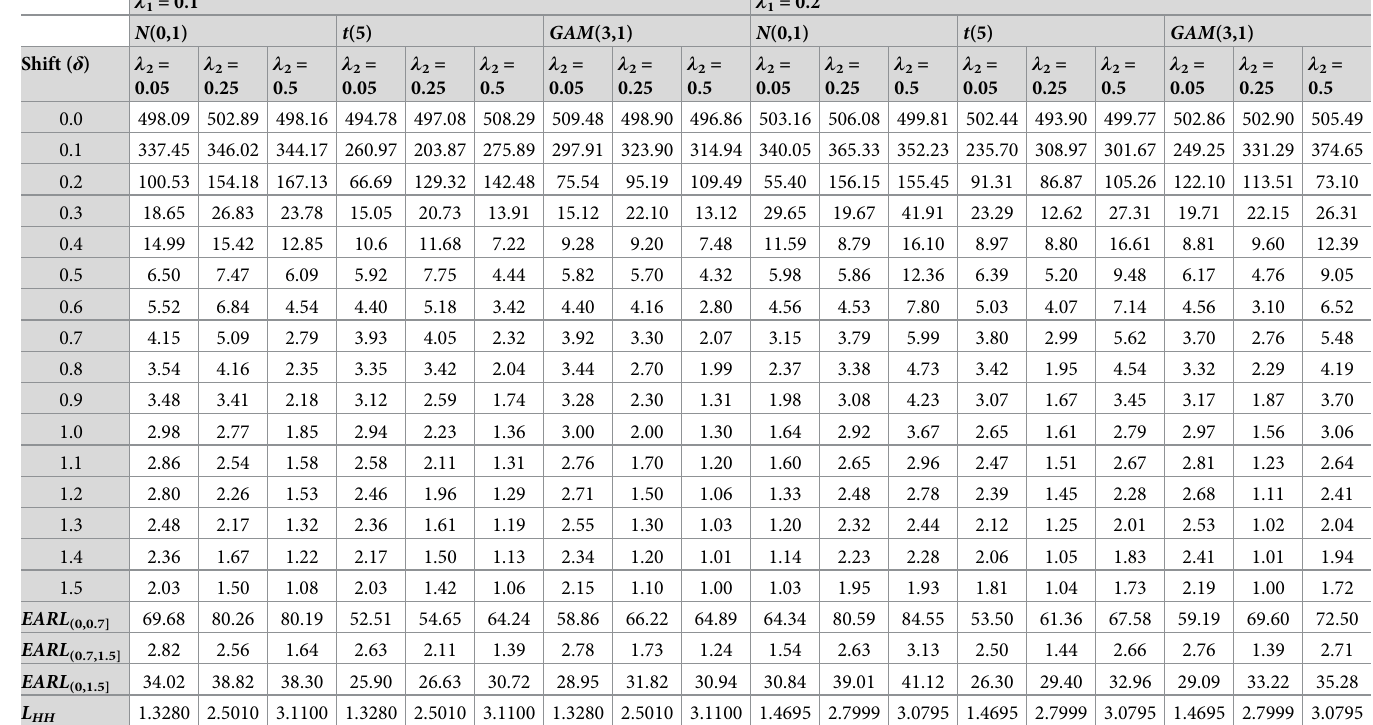
Table 4. The ARL profile of the HHWMA W scheme when ( m , n ) = (100,5), λ 1 2 {0.1,0.2} and λ 2 2 {0.05,0.25,0.5} for a nominal ARL 0 = 500 under N (0,1), t (5) and GAM (3,1) distributions. λ 1 =